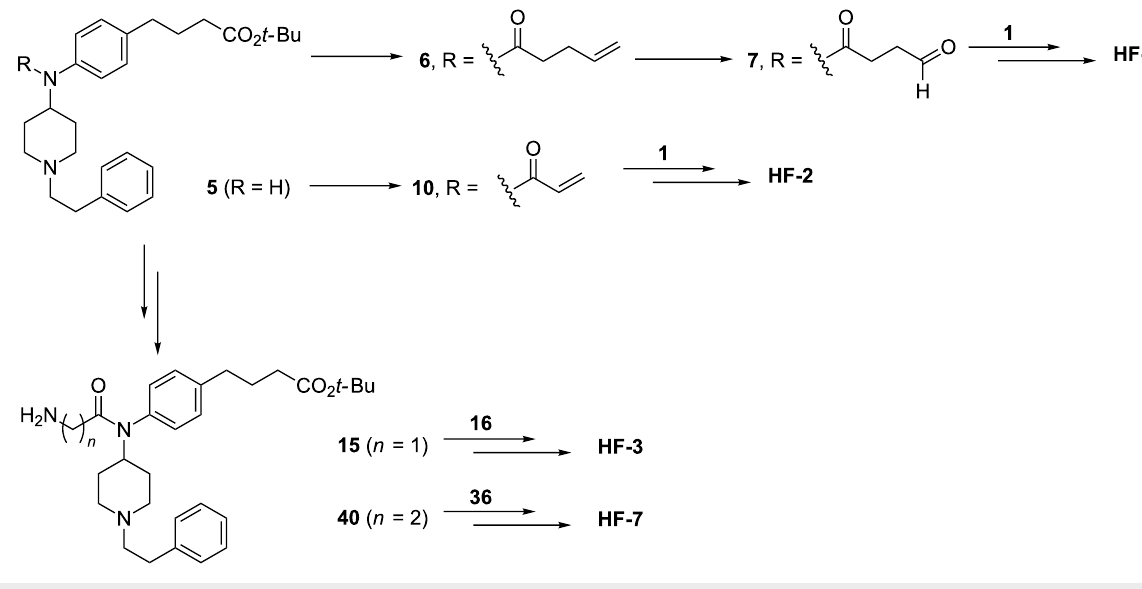
Scheme 1: General outline of HF-1 , HF-2 , HF-3 , HF-7 synthesis from fentanyl intermediate 5 and heroin intermediates 1 , 16 , and 36